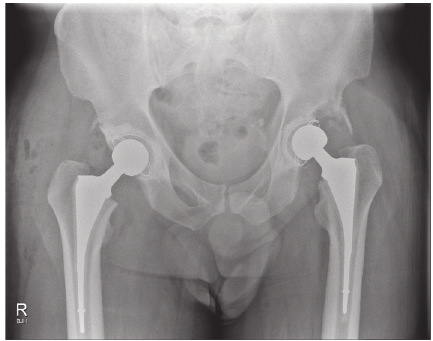
Figure 5: Postoperative radiograph demonstrating bilateral first-stage cemented total hip